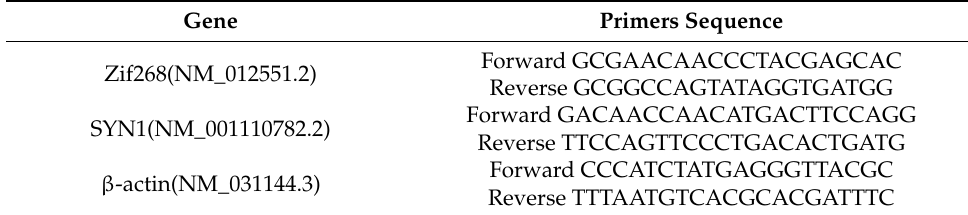
Table 1. The primers used for Quantitative Real-time PCR